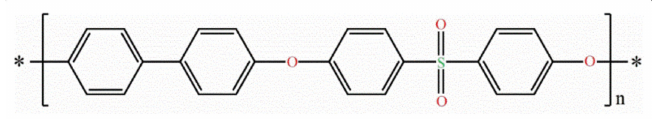
Figure 3. General structure of Polyphenylsulfone